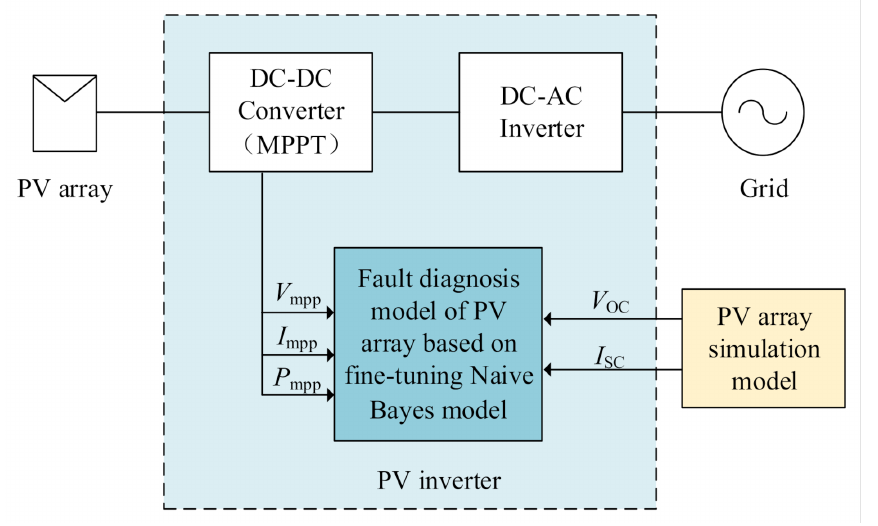
Figure 2. Fault diagnosis model of PV array based on